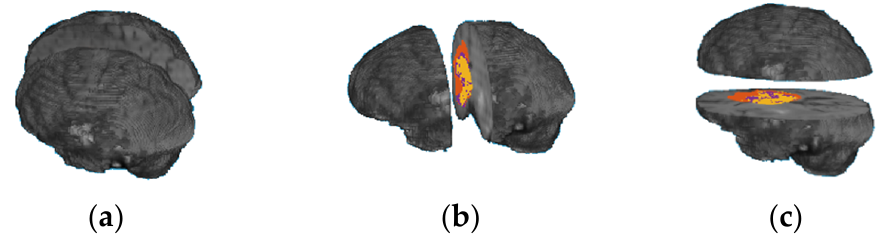
Figure 5. Two brain sub-volumes using the three section plans: ( a ) mid-sagittal; ( b ) mid-coronal; ( c ) mid-horizontal.